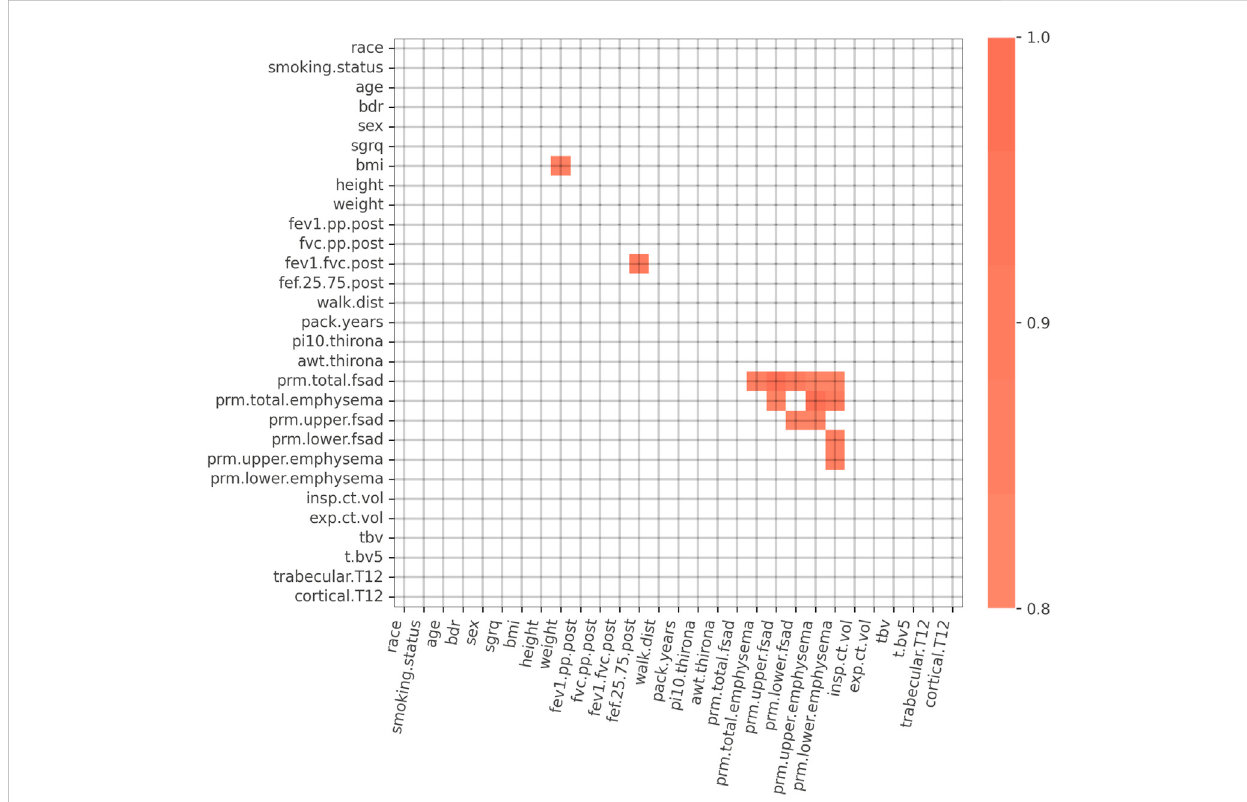
FIGURE 2 Spearman correlation matrix for the initial 29 variables. Spearman correlations > 0.80 are highlighted in orange. Strong correlations exist between PRM imaging biomarker variables, FEV 1 /FVC and FEF 25-75 , and BMI and weight. Abbreviations: bdr, bronchodilator responsiveness; sgrq, St. George ’ s Respiratory Questionnaire; BMI, body mass index; FEV1.pp.post, post bronchodilator FEV 1 % predicted; FVC.pp.post, post bronchodilator FVC % predicted; FEV1.FVC.post, post bronchodilator FEV 1 /FVC; FEF.25.75.post, post bronchodilator forced mid-expiratory fl ow; walk.dist, 6-min walk distance; pi10.thirona, square root of an airway wall area with a 10 mm lumen perimeter, measured by Thirona software; awt.thirona, segmental airway wallthickness,measured byThirona software; prm.total.fsad, PRM total fSAD > 10%;prm.total.emphysema, PRM totalemphysema > 2%;prm.upper.fsad, PRM upper lobes fSAD > 10%; prm.lower.fsad, PRM lower lobes fSAD > 10%; prm.upper.emphysema, PRM upper lobes emphysema > 2%; prm.lower.emphysema, PRM lower lobes emphysema > 2%; insp.ct.vol, CT-derived inspiratory lung volume; exp.ct.vol, CT-derived expiratory lung volume; tbv, total blood vessel volume; t.bv5, ratio of vascular tree length in vessels with a cross-sectional area less than 5 mm 2 to total vascular tree volume; trabecular.T12, average Houns fi eld unit (HU) value within the trabecular region of the T12 vertebral body; cortical.T12, average Houns fi eld unit (HU) value within the cortical region of the T12 vertebral